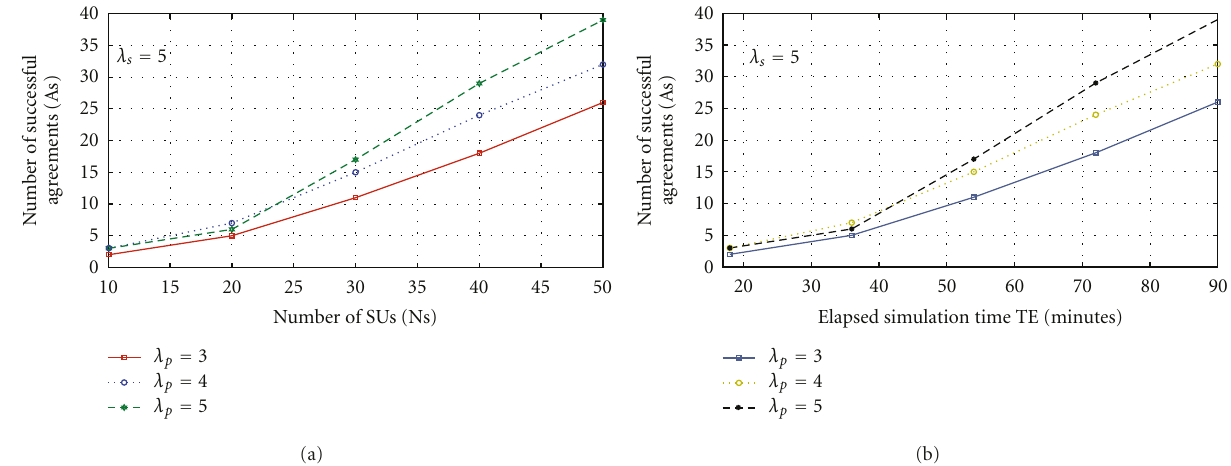
Figure 9: Successful agreements with (a) number of SUs and (b) elapsed simulation time.